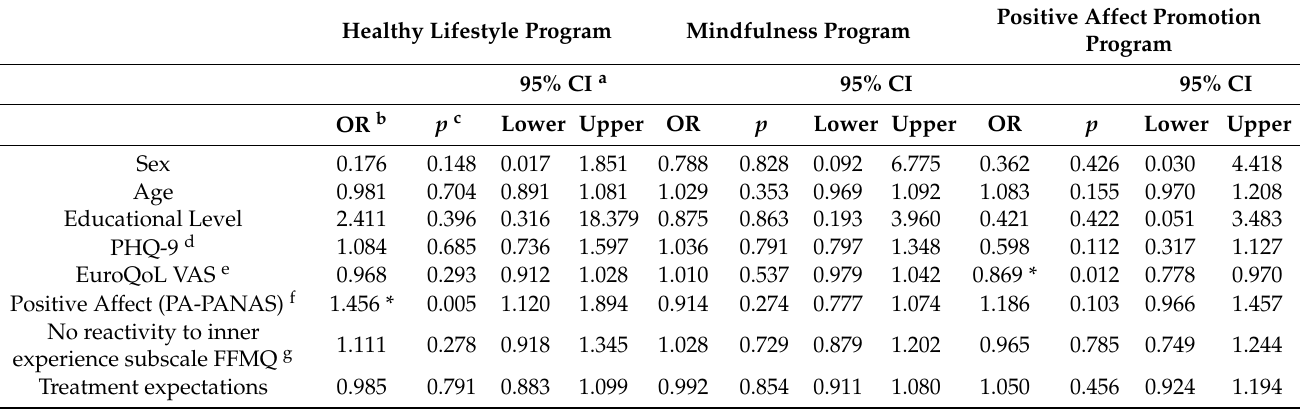
Table 2. Binary logistic regression for Healthy Lifestyle Program, mindfulness Program, and Positive Affect Promotion Program. Healthy Lifestyle Program Mindfulness